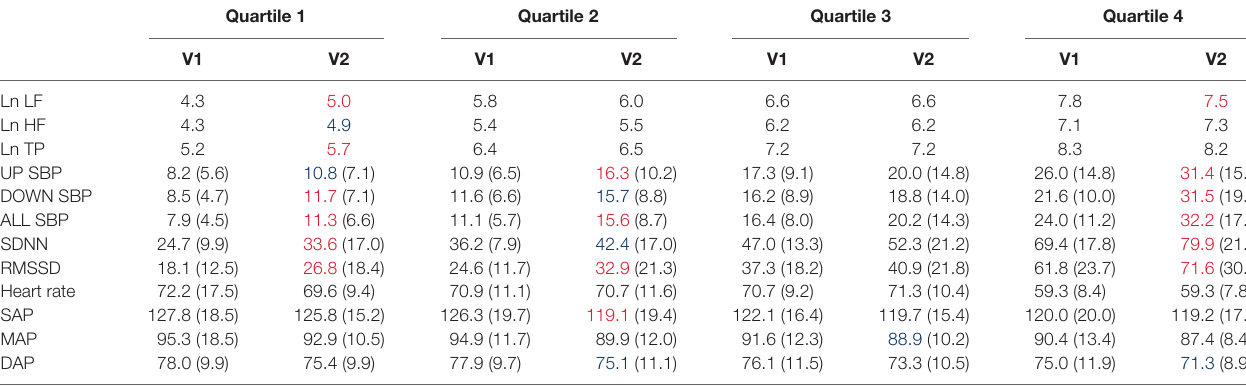
TaBle 3 | Heart rate variability (HRV), baroreflex sensitivity, and blood pressure changes by quartile of low-frequency (LF) power. Quartile 1 Quartile 2 Quartile 3